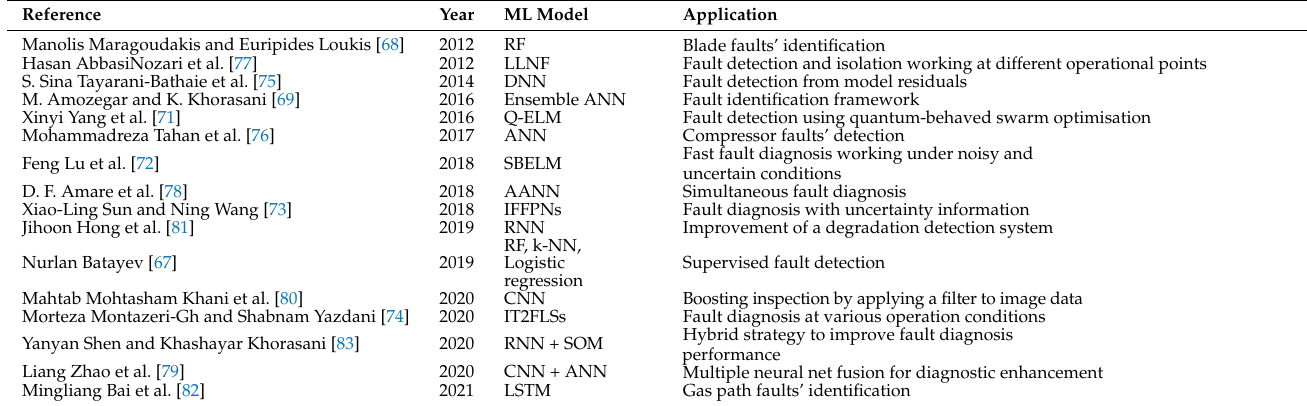
Table 3. Summary of the presented methods for fault detection using machine-learning models.